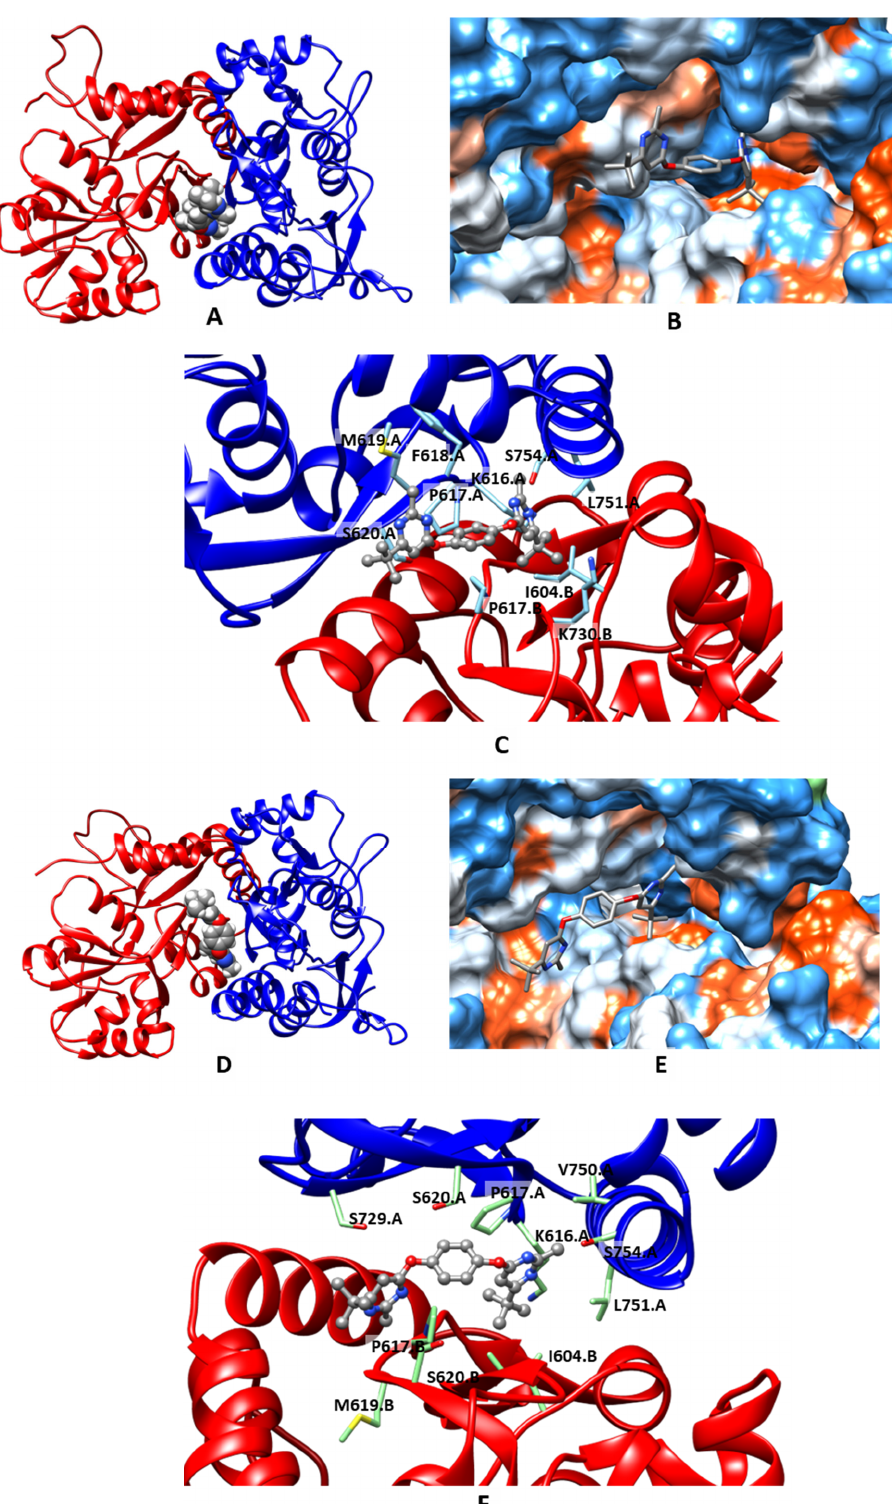
Figure 3. Binding mode of the PAM 1f , refined using molecular dynamics simulation (150 ns). ( A ) General view of the dimeric ligand binding domain of AMPA receptor (GluA2) and location of the binding site. ( B ) Binding pockets on the protein molecular surface colored by local hydropho ‐ bicity (brown for hydrophobic and blue for hydrophilic). ( C ) Detailed view of the binding site. The ligand is represented by a grey ball ‐ and ‐ stick model; the amino acid residues located within 3 Å of it are represented by beige stick ‐ models.